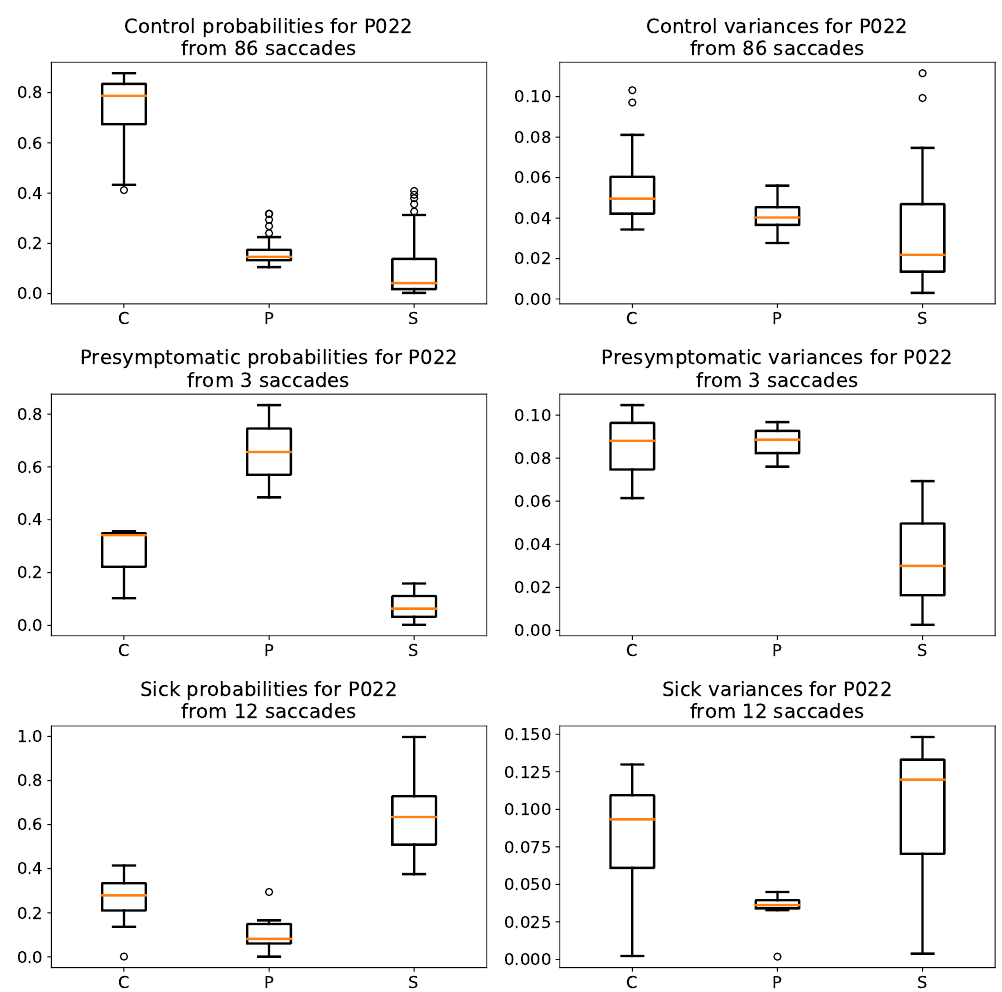
Figure 3. Box plots with probabilities and variances for classes C, P and S reached by the Monte Carlo dropout (MCD) runs for the presymptomatic register P022. Each row corresponds to the saccades that were classified as control ( top ), presymptomatic ( middle ) and sick ( bottom ).